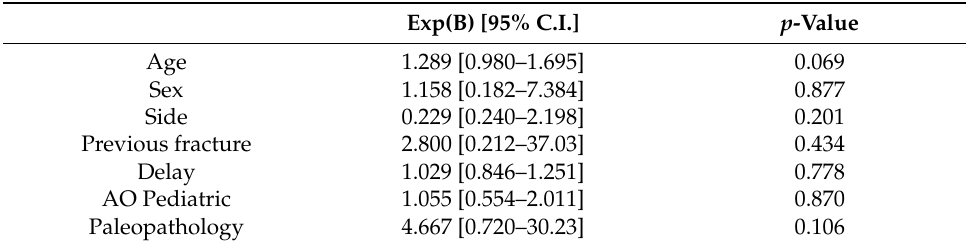
Table 4. Univariable binary logistic regression